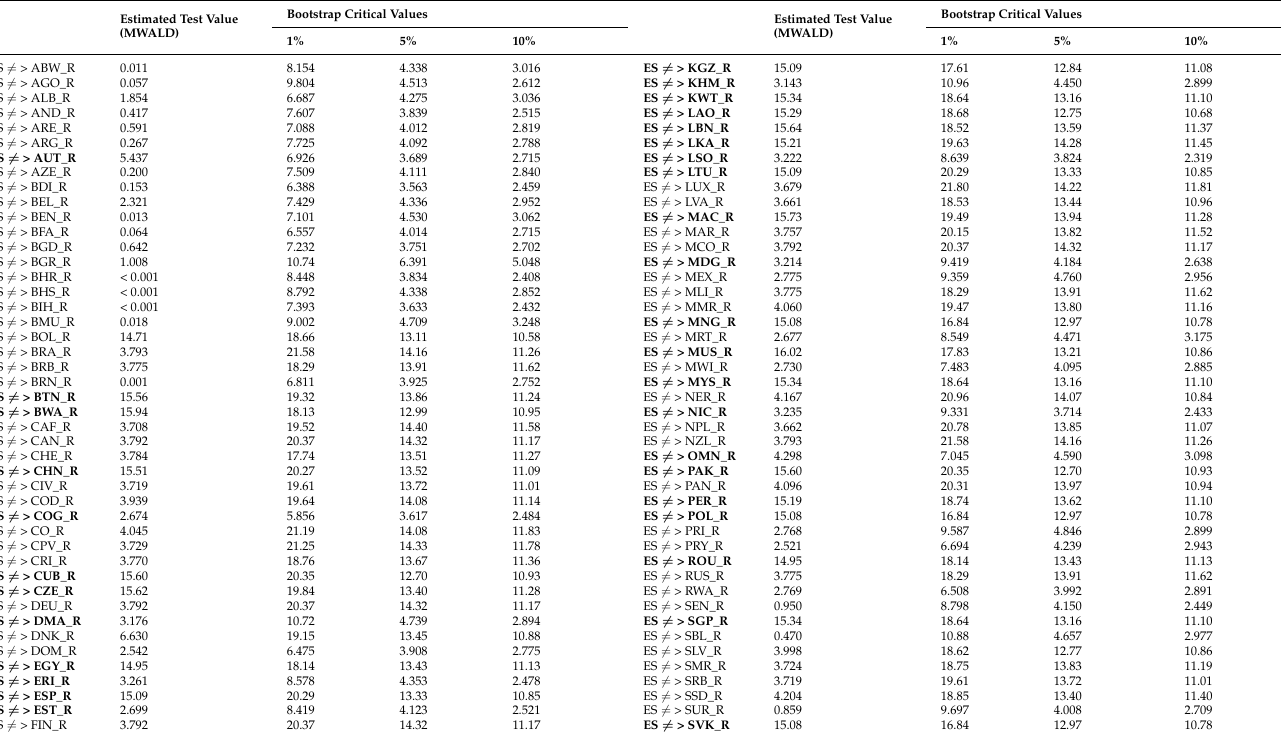
Table 7. Bootstrap Toda–Yamamoto causality tests between economic supports and Bitcoin return